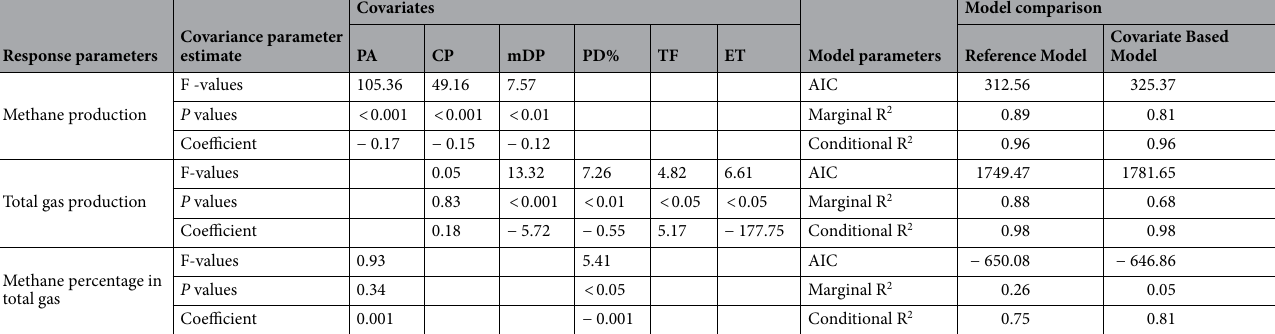
Table 3. The relationship between forage quality traits and the in vitro fermentation end-products (methane production (ml/200 mg DM), gas production (ml/200 mg DM), and methane percentage in total gas (%)) was estimated by stepwise regression using forward selection. The table shows the model performance of the covariate- based model using measured forage quality parameters (PA, proanthocyanidins (g/kg DM); CP, crude protein (g/kg DM), mDP, mean degree of polymerisation; PD%, prodelphinidin percentage in PA; TF, total flavonols (sum of myricetin, quercetin and kaempferol concentration, gkg DM); ET, ellagitannins (g/kg DM)) as covariates and its comparison with the reference model. For the R 2 values of the model, marginal R 2 values (variance explained by fixed effects only) and conditional R 2 values (variance explained by the entire model including both fixed and random terms) are